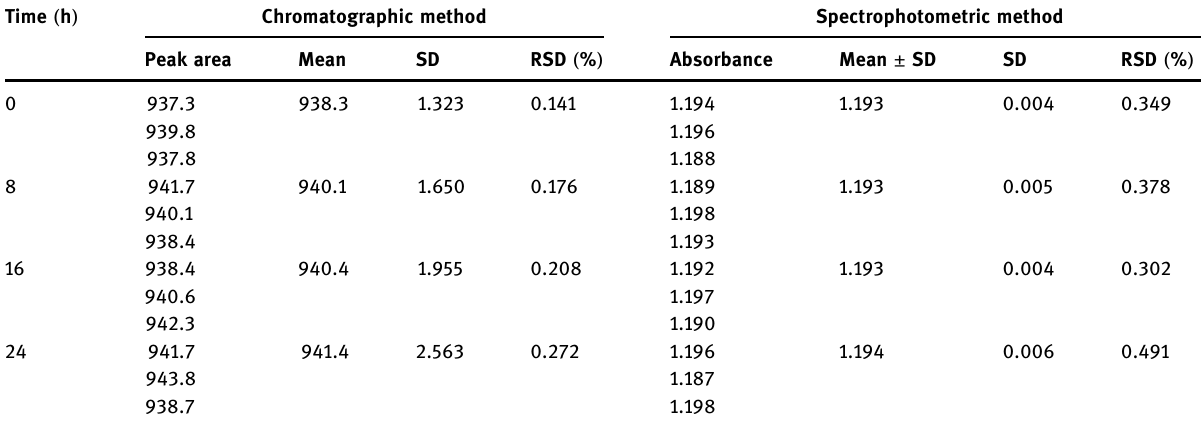
Table 7: The results of standard solution stability ( n = 3, 20 μ g · mL − 1 ) Time ( h )